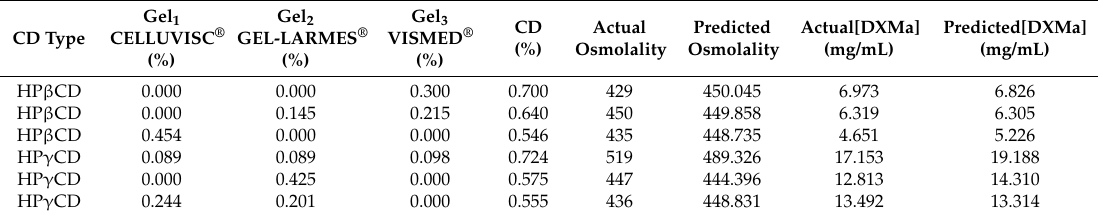
Table 7. Variables setting combination used for models confirmation samples ( n = 2).